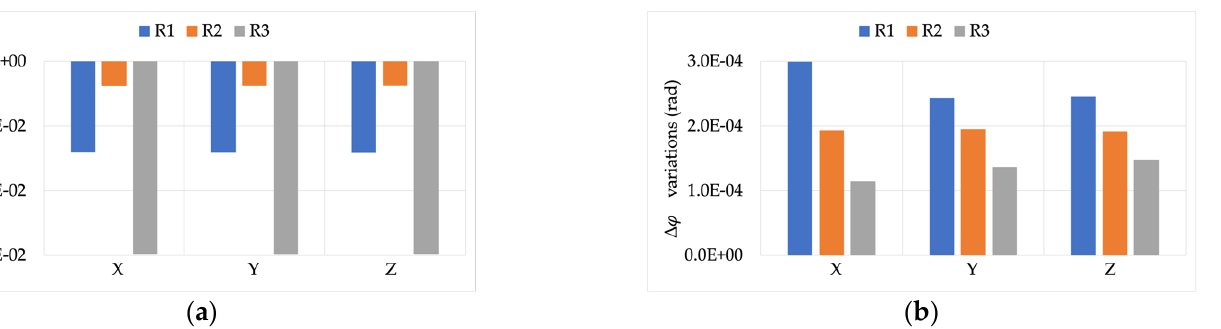
Figure 9. 𝜀 and ∆𝜑 variations (( a , b ), respectively), compared to position L, for the three signals measured with position M.